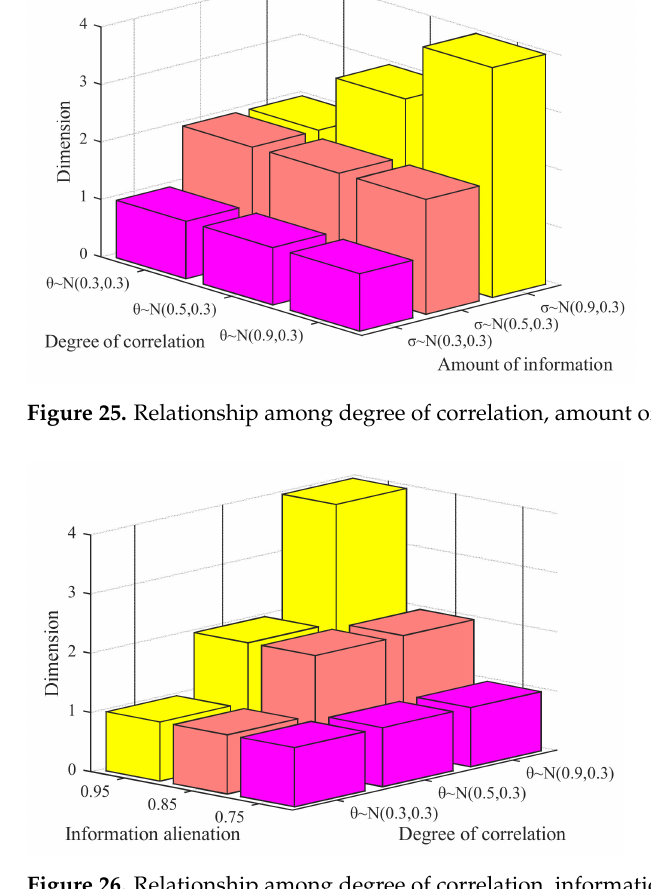
Figure 26. Relationship among degree of correlation, information alienation and dimension.